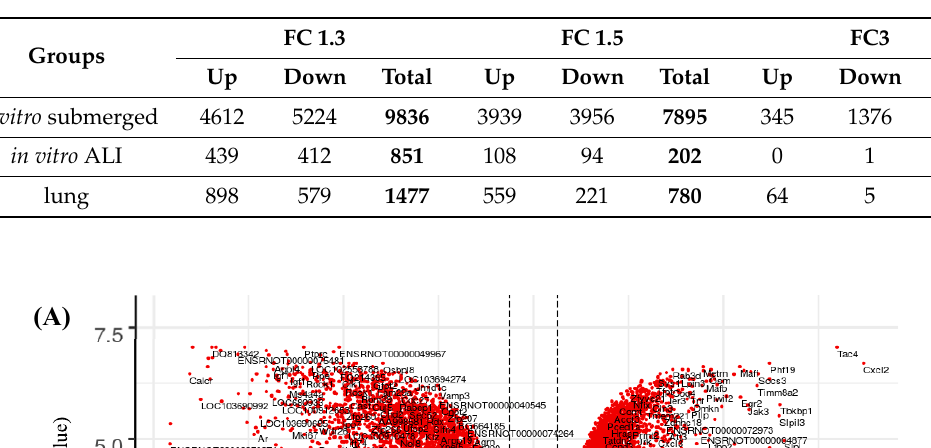
Table 2. Total number of di ff erentially expressed genes (FDR corrected p -value < 0.05).